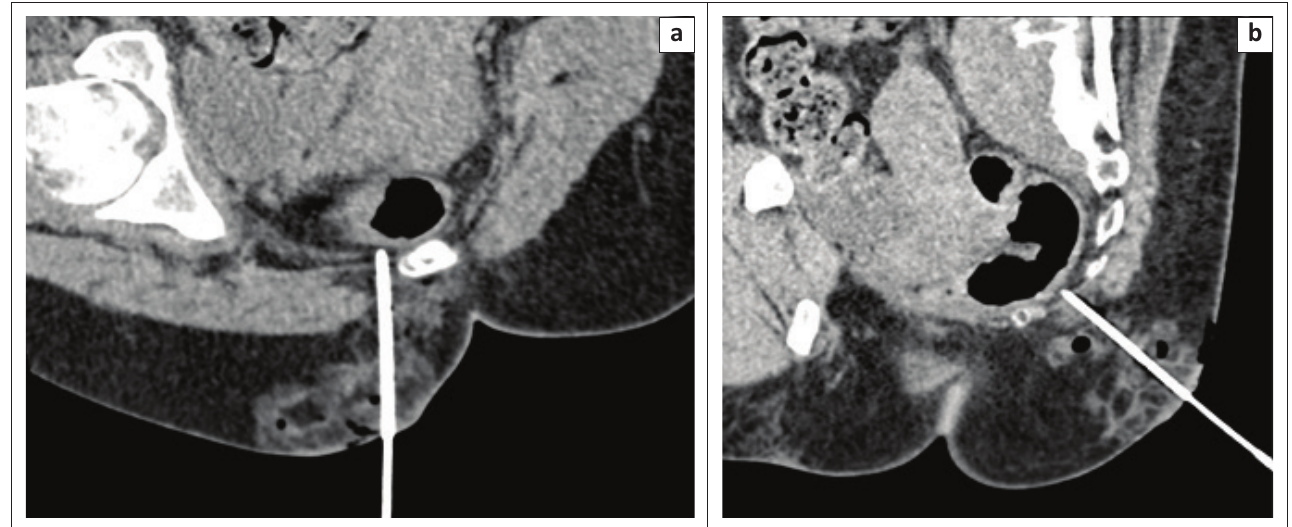
FIGURE 2: (a and b) Oblique axial and sagittal images show the tip of the needle (21G) at the level of the S5 vertebra in the presacral space with the rectum immediately antero-lateral to it.